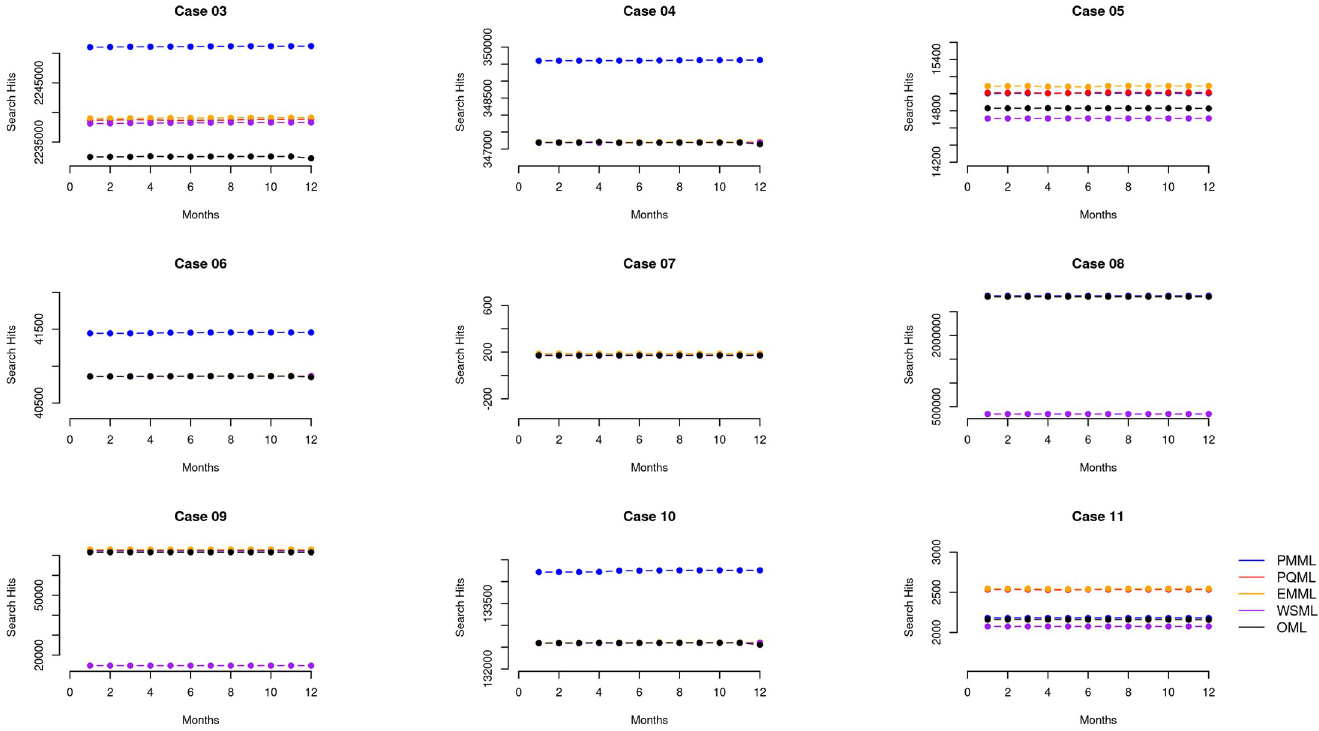
Fig 3. Macro view of cases #03–#11. A macro perspective of search result counts for cases #03-#11 that were restricted by publication date. The individual plots are case by case and each plot compares the count of retrieved items for the five MEDLINE platforms across the twelve months of data collection. The macro perspective highlights differences among the ranges of records retrieved among the platforms in each case but it does not capture the detailed variation or trends that occurs when comparing retrieved results among the platforms.